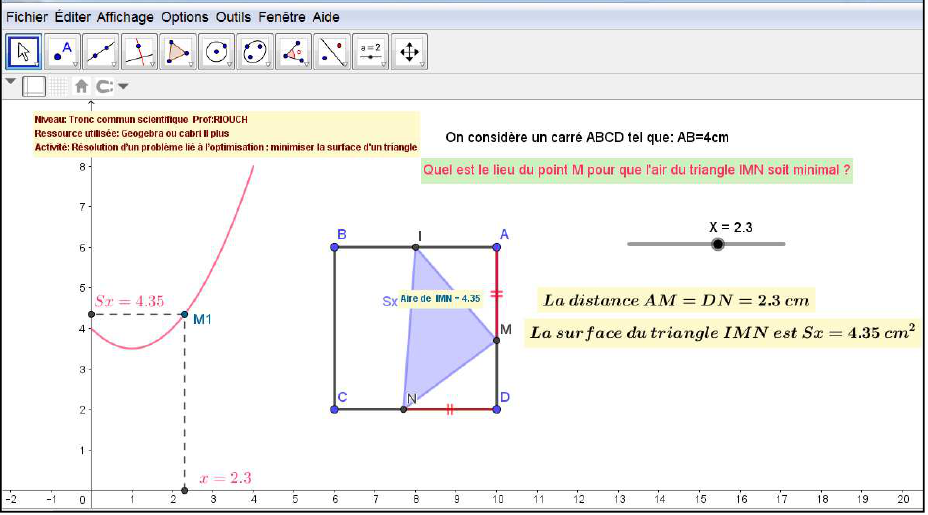
Fig. 6. Simulation du problème d’optimisation avec un logiciel de géométrie dynamique